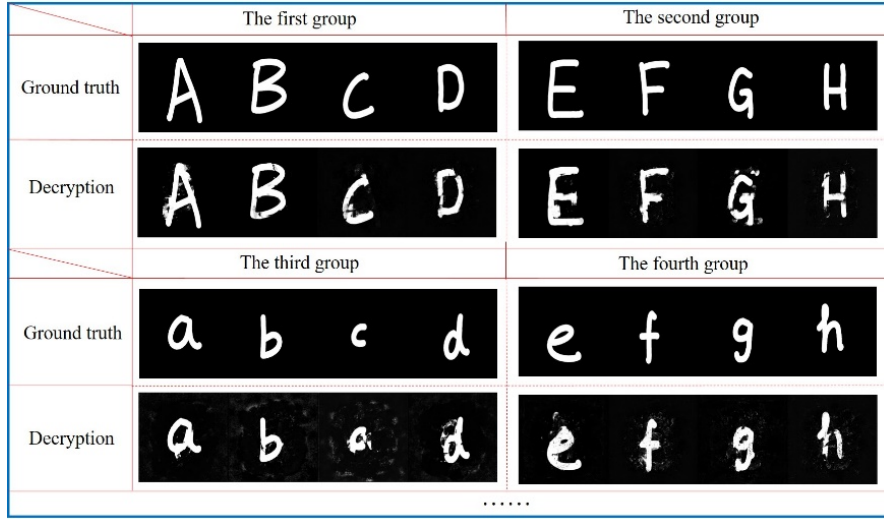
Figure 8. Testing results for handwritten English alphabet.